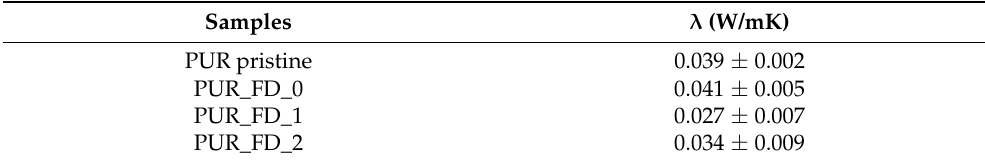
Table 3. Thermal conductivity of the selected foams.